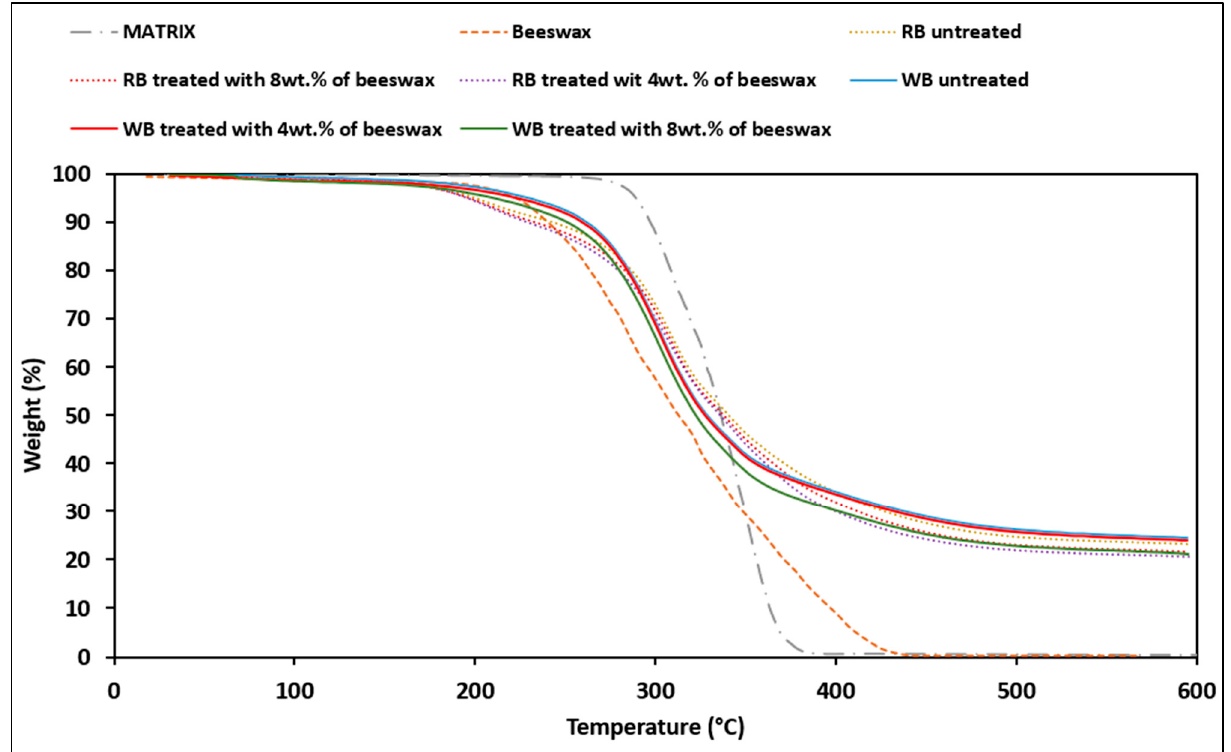
Figure 1. TGA of beeswax, PLA/PBSA matrix, Wheat Bran and Rice Bran with and without different percentage of beeswax treatment.